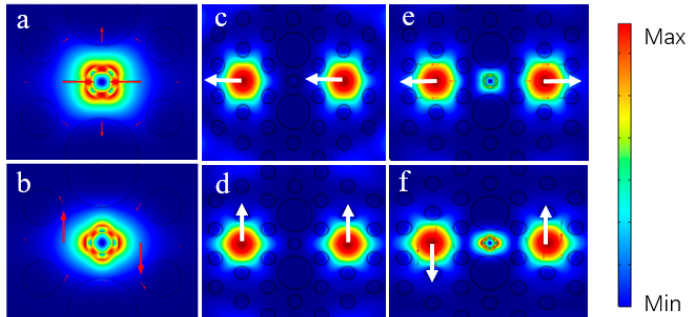
Figure 2. Electric field distributions of the fundamental modes (FMs) for the proposed PCF-PBS at 1.55 µ m. ( a ) The x-polarization ring mode (x-RM), ( b ) the y-polarization ring mode (y-RM), ( c ) the x-polarization even mode (x-pol EM), and ( d ) the y-polarization even mode (y-pol EM); the resonance state between the ( e ) x-RM and the x-polarization odd mode (x-pol OM) and the ( f ) y-RM and the y-polarization odd mode (y-pol